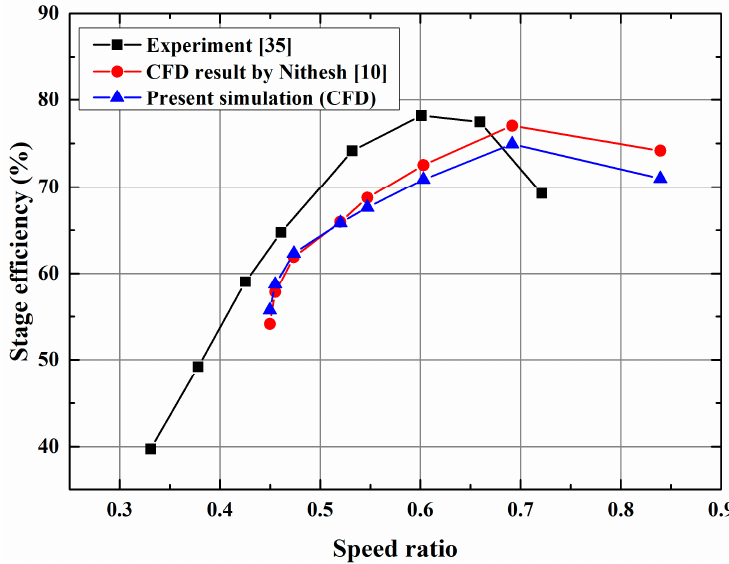
Figure 7. The validation of the numerical approach.